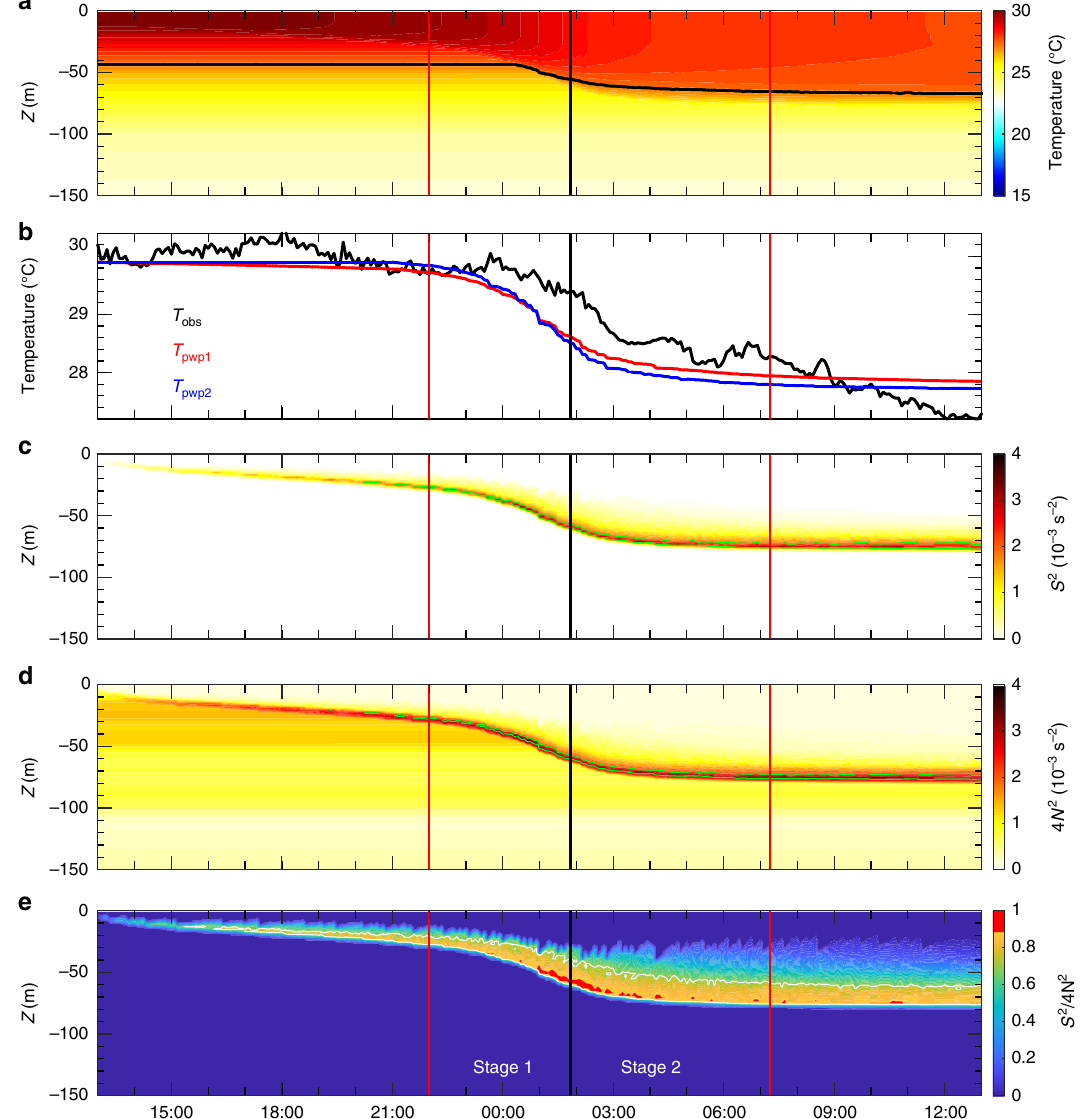
Fig. 4 Results from the PWP model and a comparison of observational and modeling results at NTU1. a Model-produced temperatures. b Time series of the upper 25 m-averaged temperatures obtained from the observations ( T obs ), from the PWP model-produced temperature ( T pwp1 ), and from similar model settings but with a zero surface heat fl ux-produced temperature ( T pwp2 ). Model data-derived parameters: c shear square S 2 , d four times of buoyancy frequency square 4 N 2 , and e S 2 /4 N